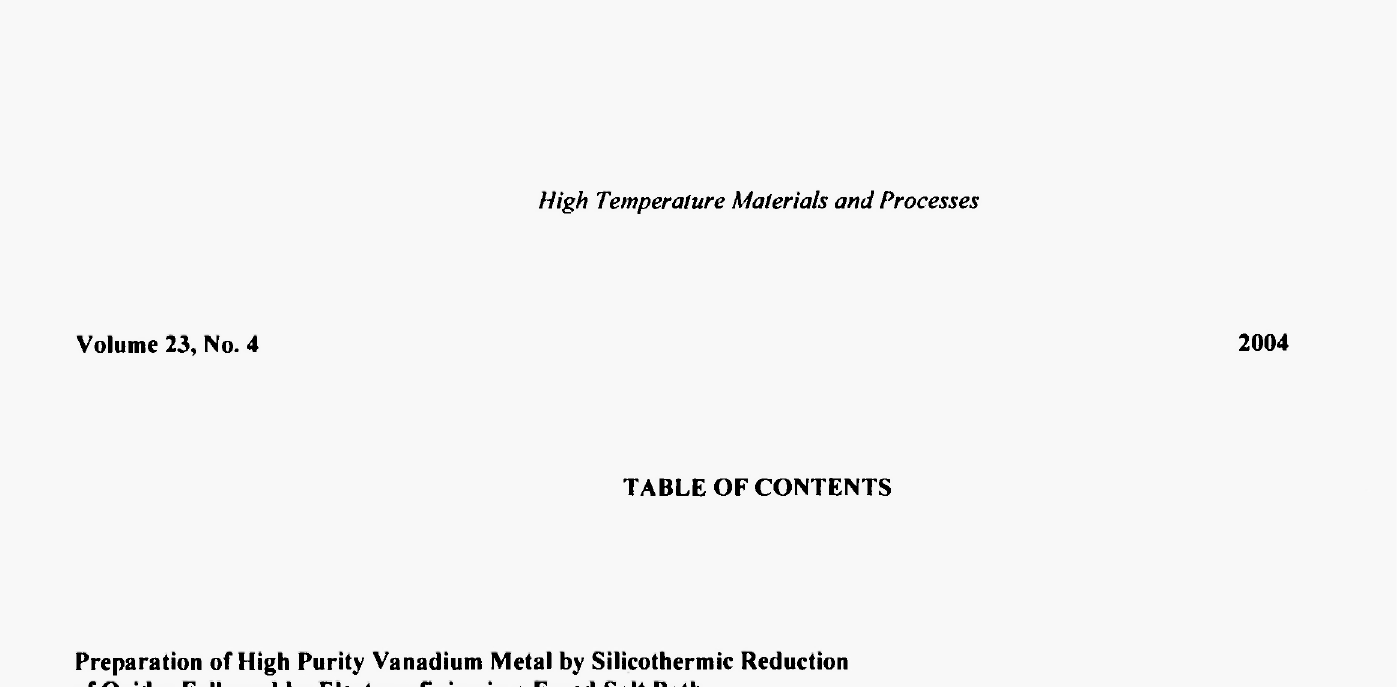
Preparation of High Purity Vanadium Metal by Silicothermic Reduction of Oxides Followed by Electrorefining in a Fused Salt Bath